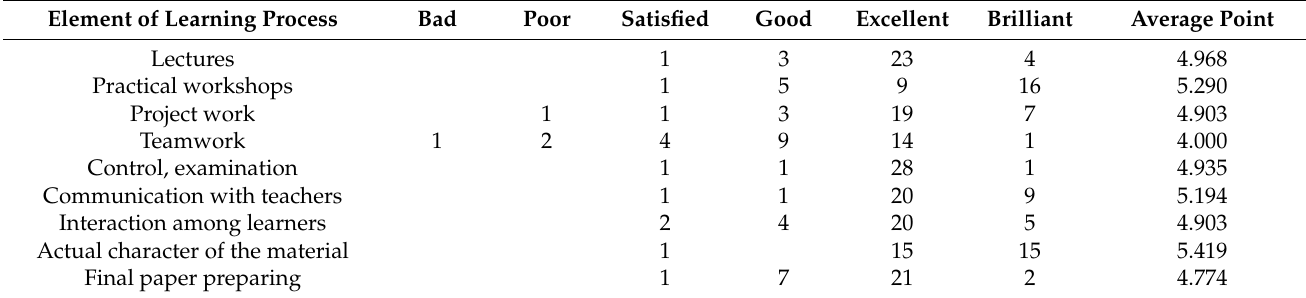
Table A2. Points awarded by students on the elements of the organization of the educational process, September 2020 (N2 = 31). Element of Learning Process